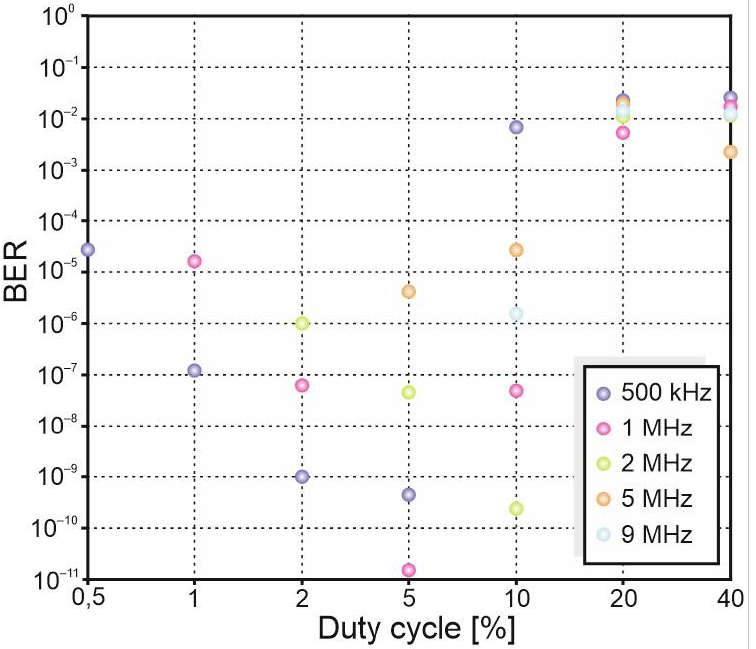
Figure 8. BER values for different pulse duty factors and frequencies at the laser operating temperature of 0 °C.